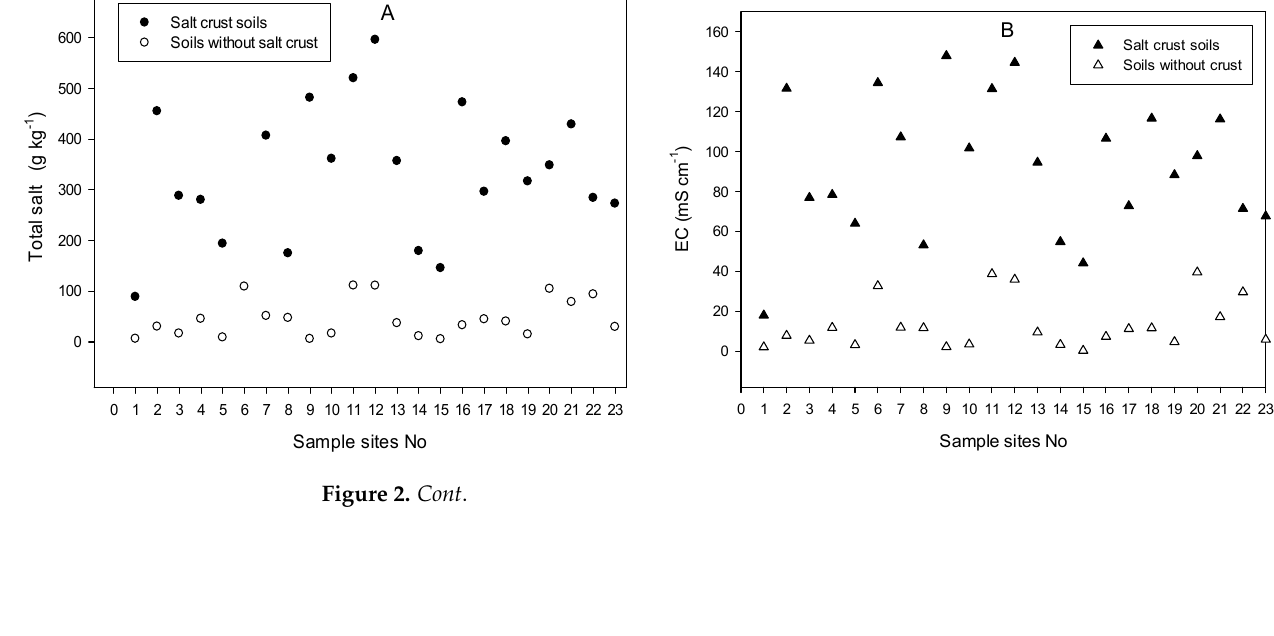
Table 1. Summary statistics of soil properties.